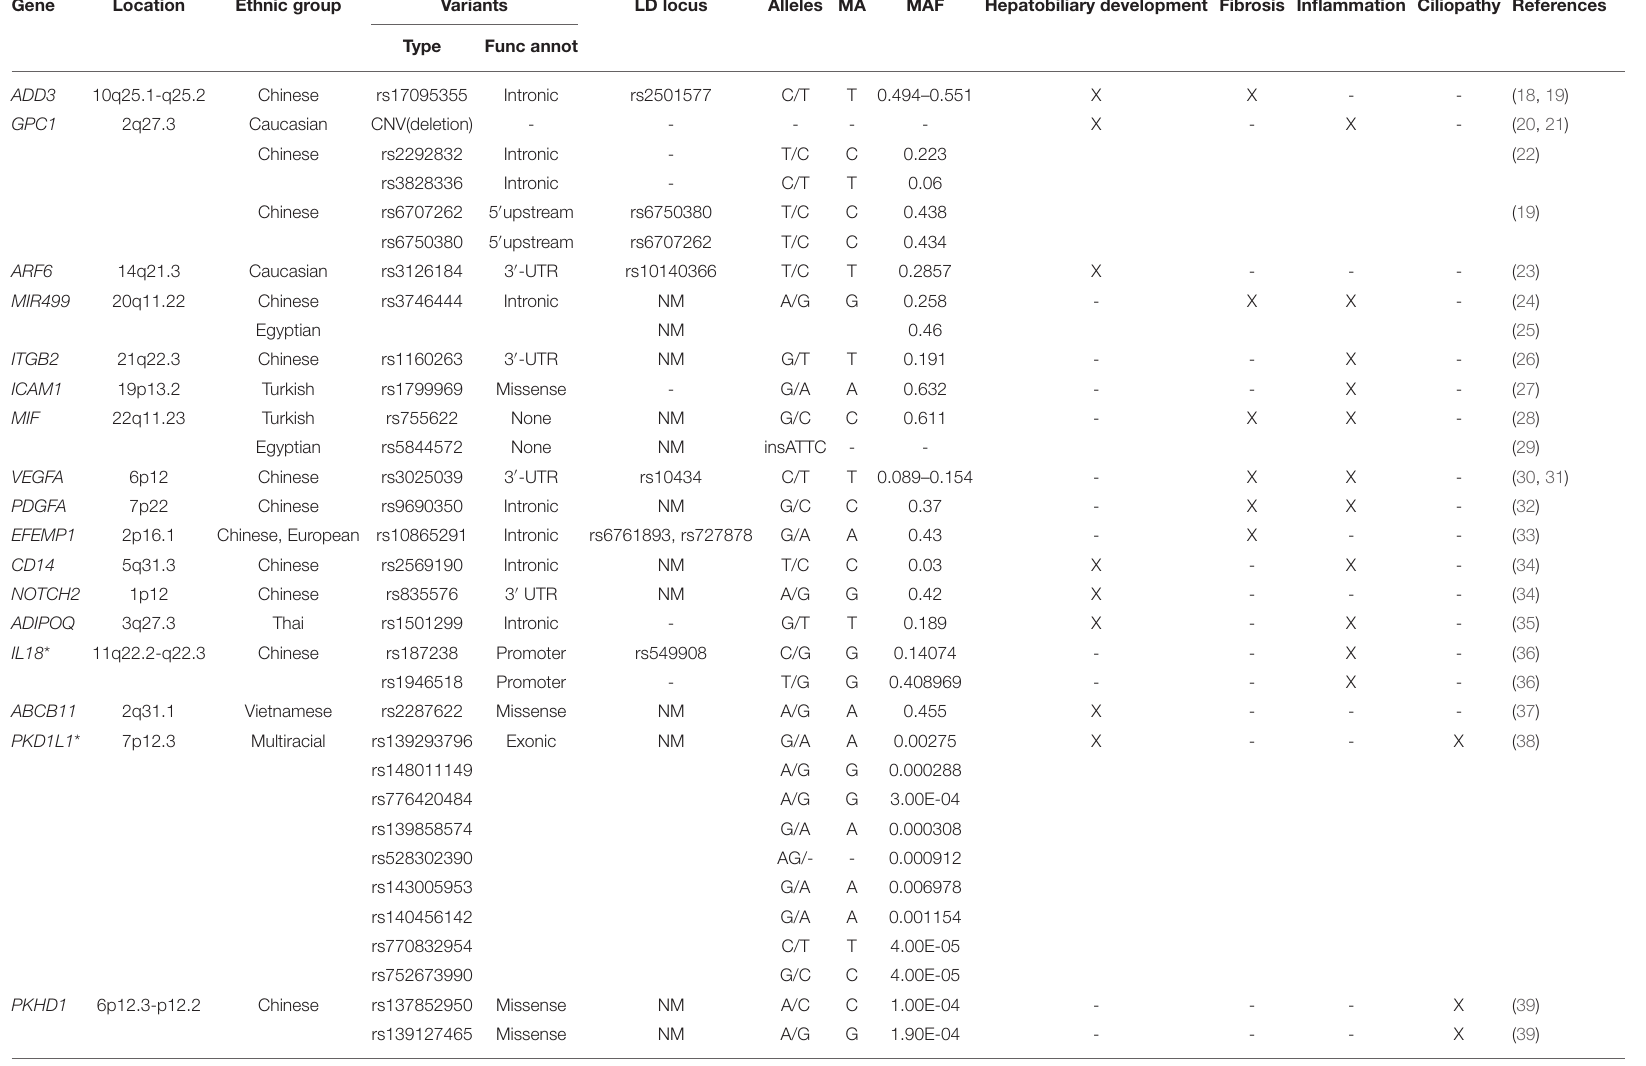
TABLE 1 | Gene variants in BA and their potential role in the pathogenesis of